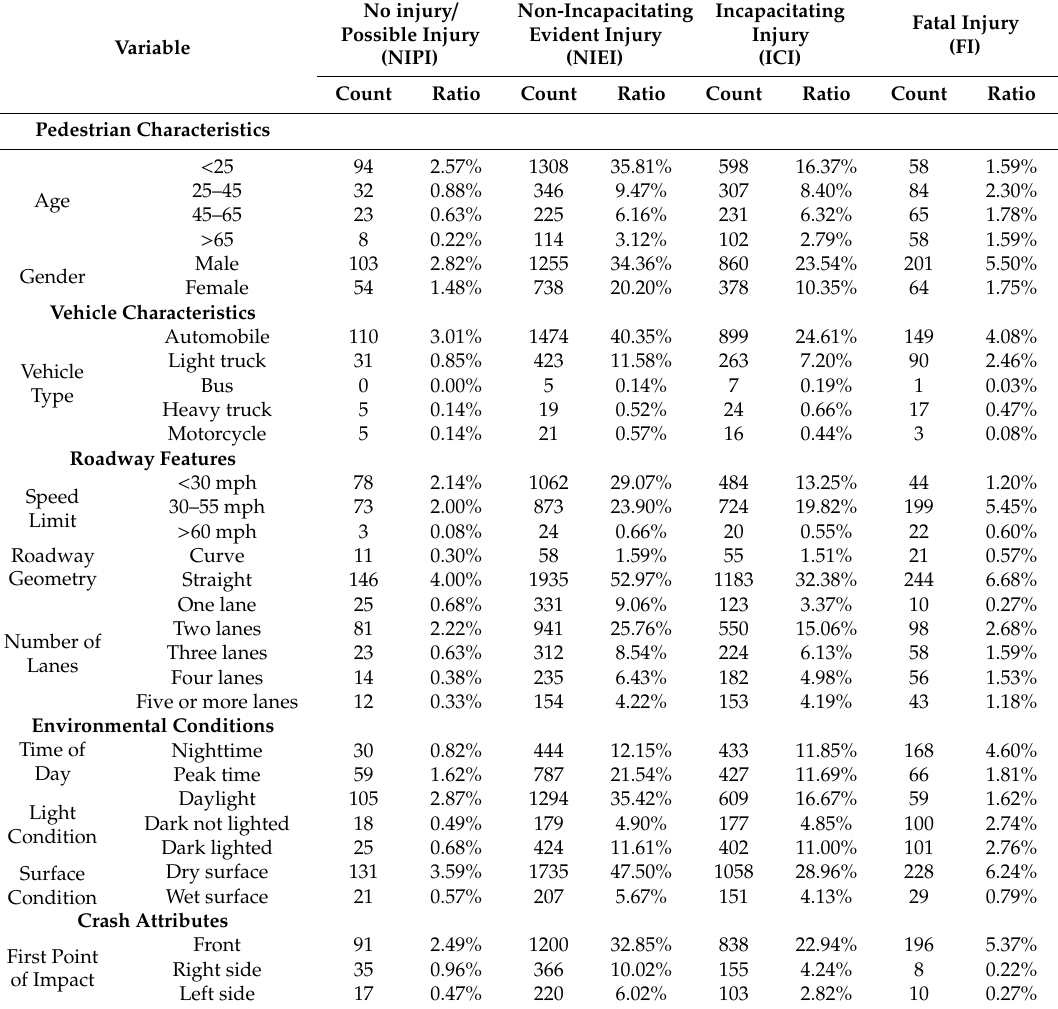
Table 1. Distribution of potential contributing factors at di ff erent severity